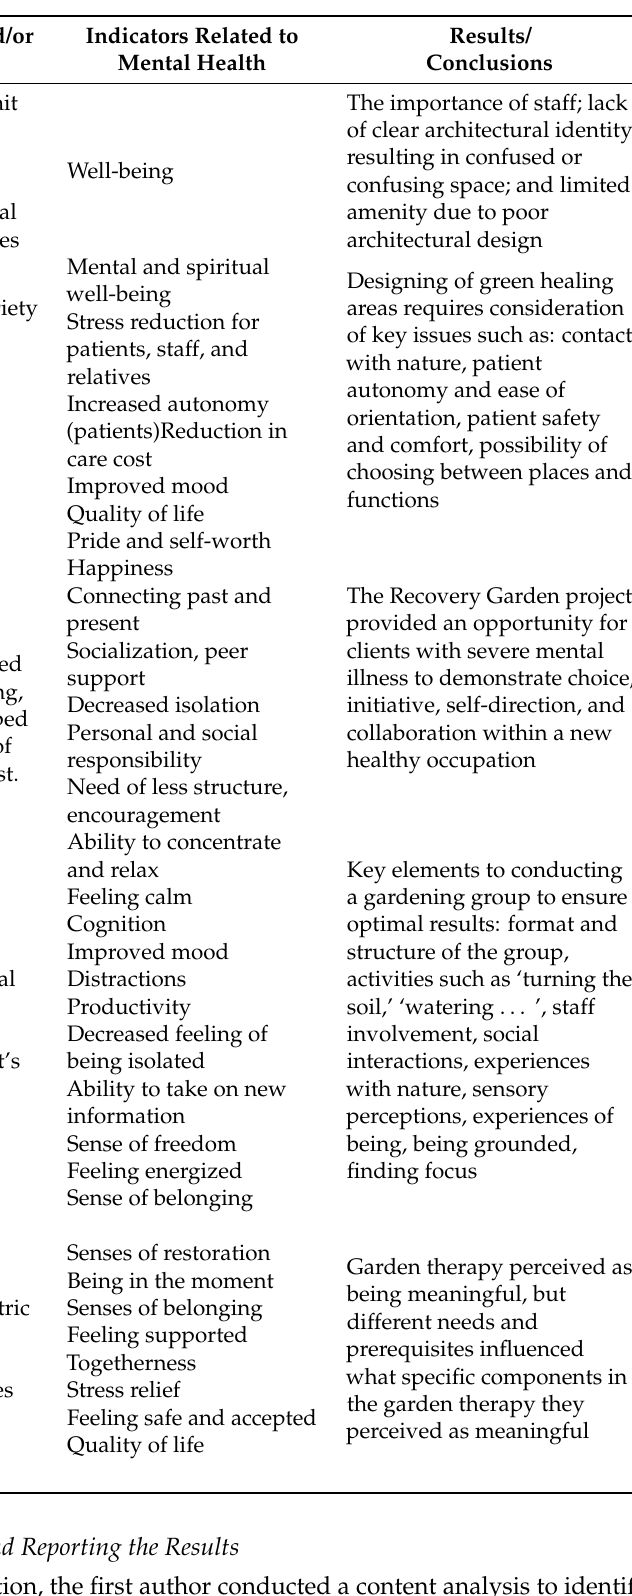
Table 3. Overview of the